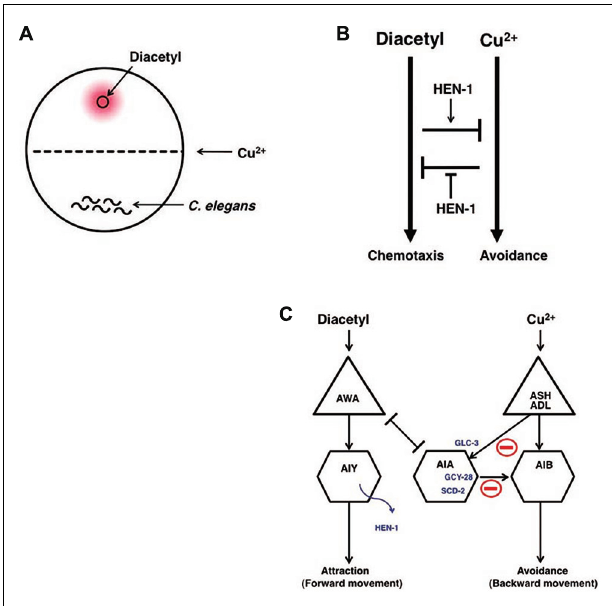
FIGURE 5 | Neural integration of two different types of information and decision on behavioral choice (Ishihara etal., 2002; Shinkai etal., 2011). (A) The assay system of interaction assay. (B) The reciprocal inhibition model of the attractive signaling to diacetyl and the avoidance signaling to Cu 2 + . (C) A neural circuit model of the interaction of two sensory signals and decision-making.The activity of AIA interneurons is regulated by the balance between excitatory inputs from AWA through the gap junction and inhibitory inputs from ASH and ADL neurons through the glutamate-gated chloride channel GLC-3. Activated AIA interneurons would increase the relative strength of the signals for diacetyl by inhibiting the signals for Cu 2 + . GCY-28 and SCD-2 may enhance the inhibitory synaptic outputs from AIA neurons. HEN-1, a secretory protein released from AIY neurons, may act on the receptor SCD-2.The details of the mechanism of HEN-1 action are not yet fully